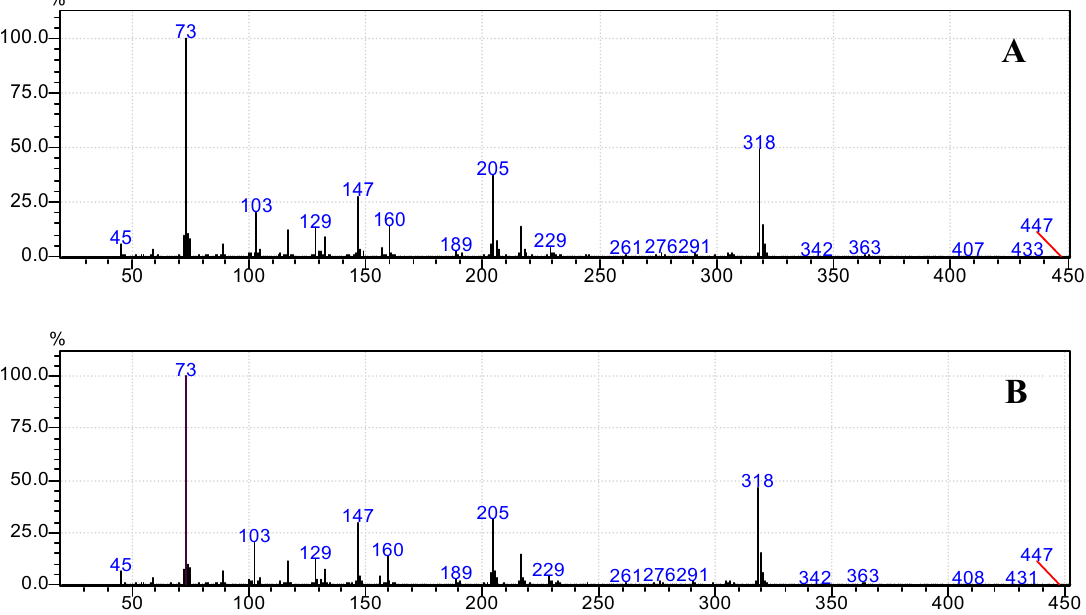
Figure 8. Mass spectrum at a retention time of 3.95 min. ( A ) Standard D -glucose; ( B ) Date juice.